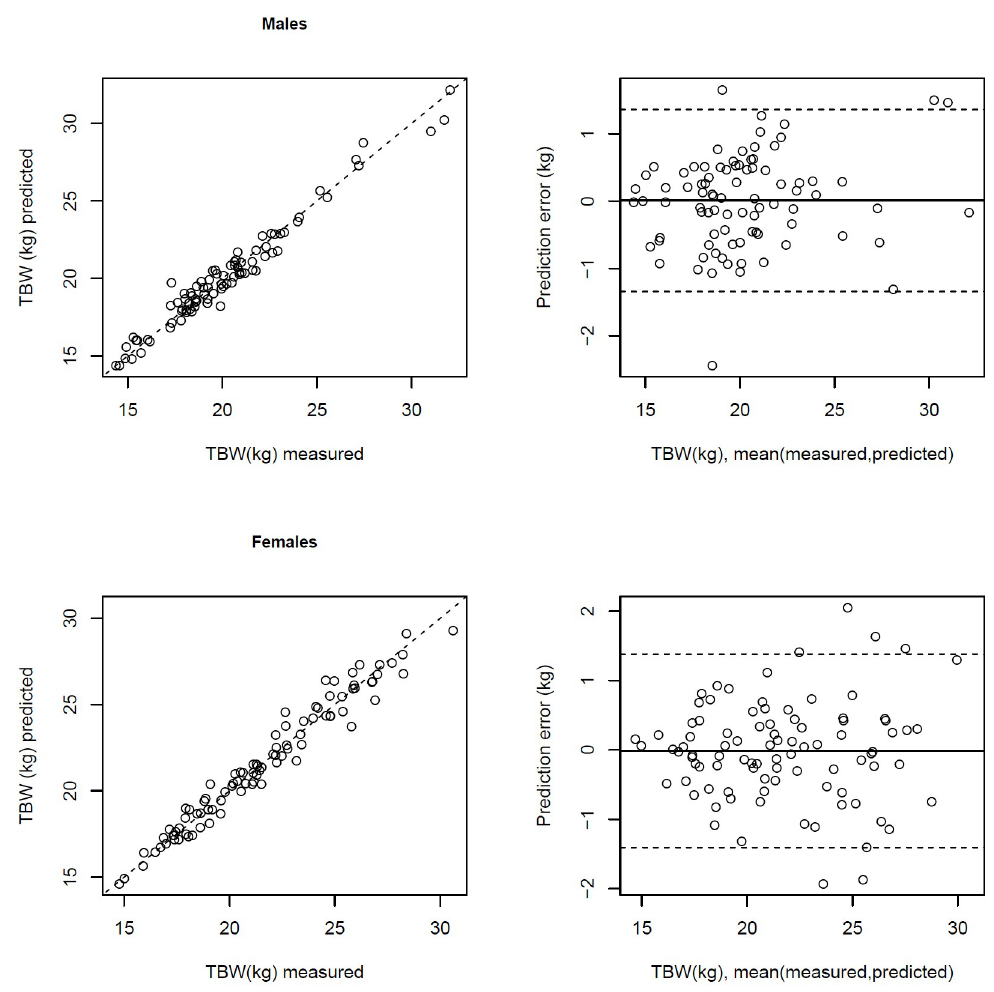
Fig 2. Correlation between total body water (TBW) in kg measured by deuterium dilution with TBW (kg) predicted by bioimpedance using the predictive equation in Table 4 (r 2 = 0.96 for males, 0.96 for females), and Bland-Altman plots showing the difference in TBW (kg) measured by deuterium dilution and predicted by the bioimpedance equation against their mean.